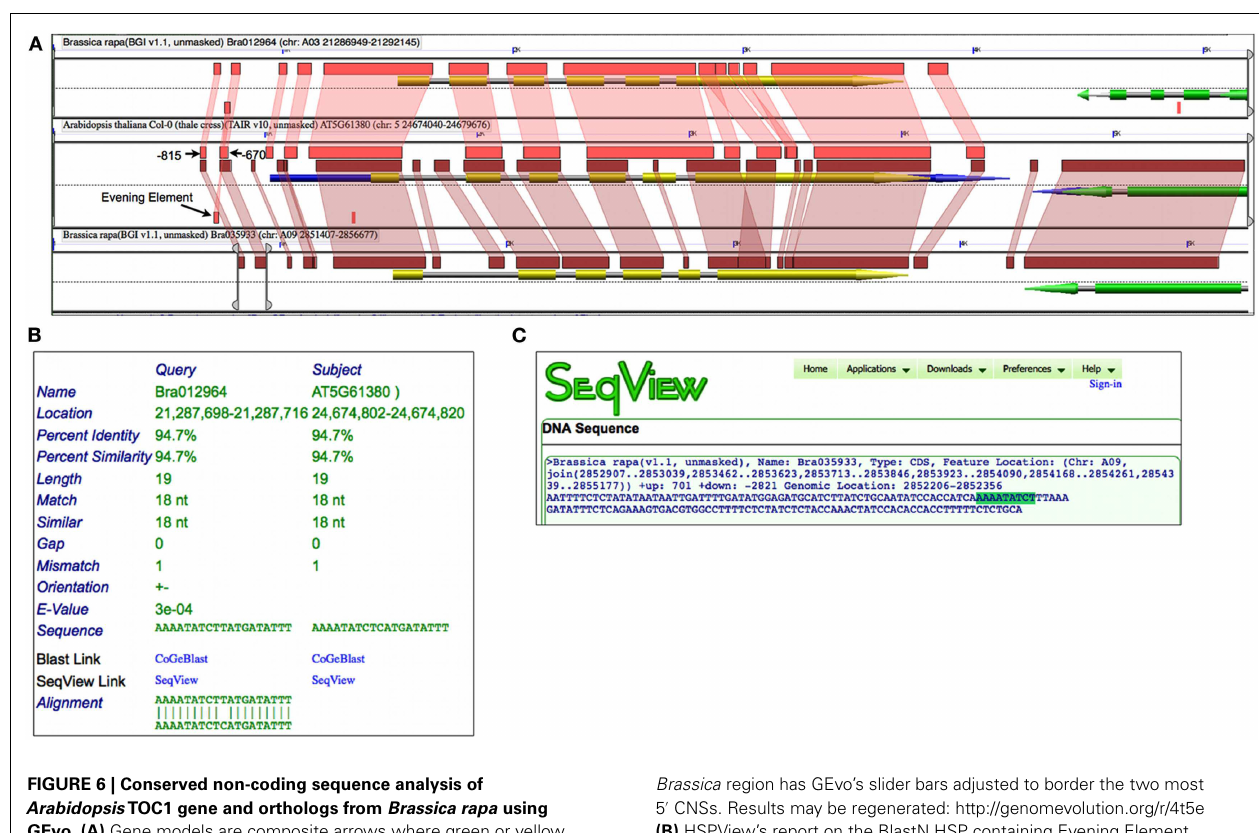
FIGURE 6 | Conserved non-coding sequence analysis of Arabidopsis TOC1 gene and orthologs from Brassica rapa using GEvo. (A) Gene models are composite arrows where green or yellow regions represent protein coding sequence, blue is mRNA, and gray is the full extent of the gene. Regions of sequence similar are as in Figure 5 and were identified using BLASTN; such regions are in the opposite orientation if drawn below the dashed line.The bottom